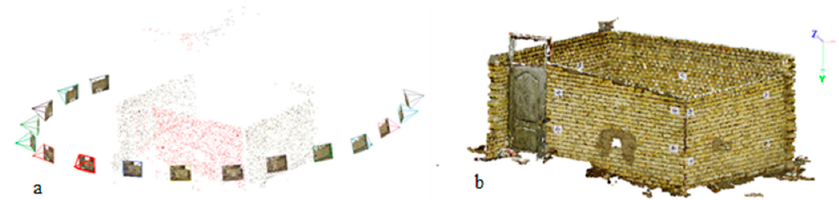
Figure 6. Generated point could for the first case study: ( a ) The sparse point cloud, ( b ) the dense point cloud.